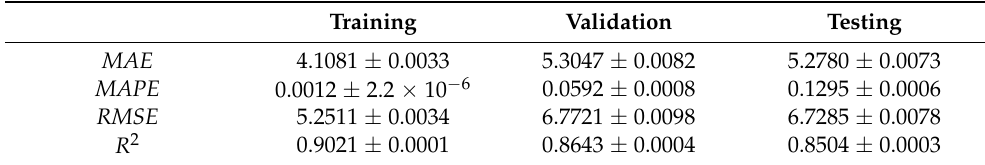
Table 5. Evaluation of the predictive performance of the proposed model.